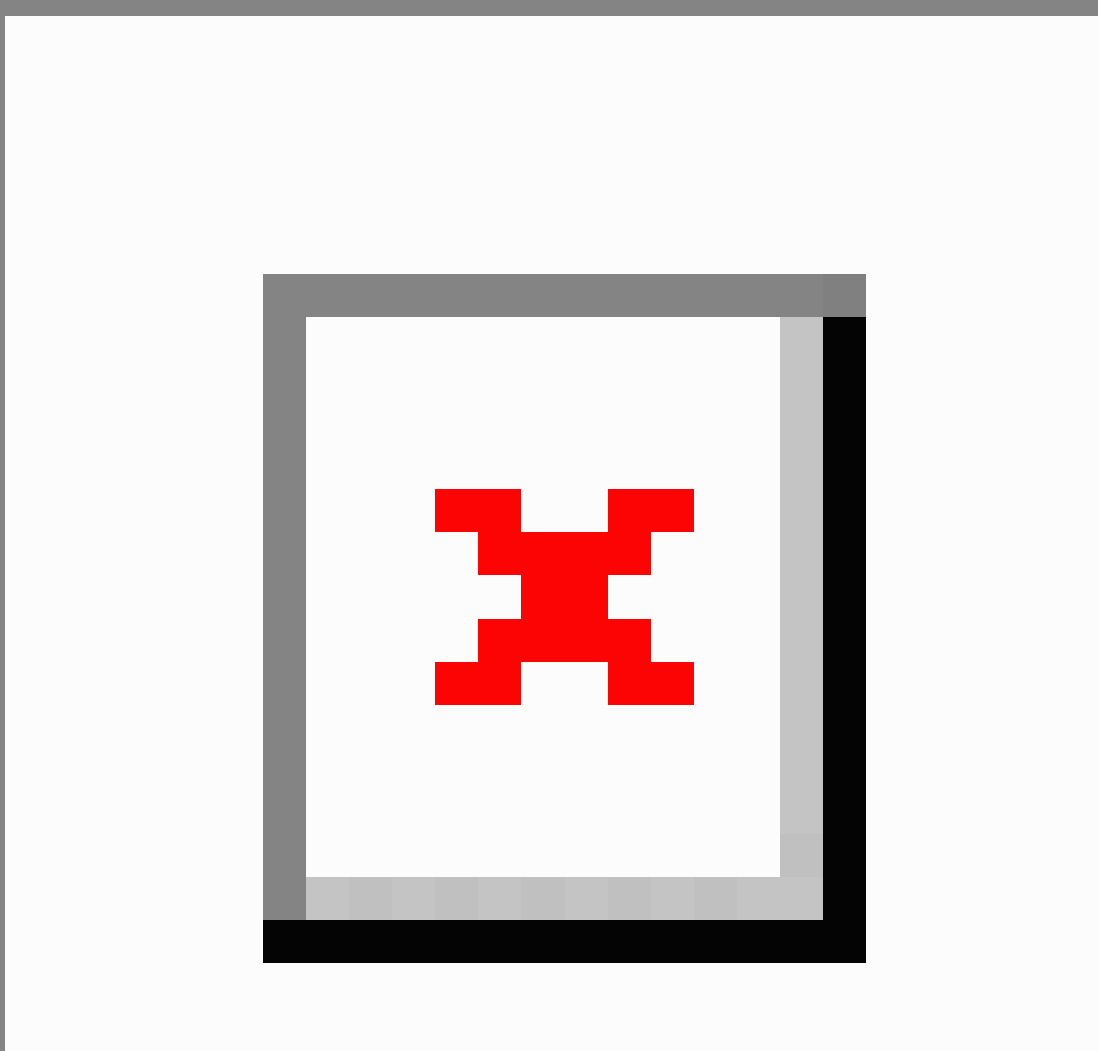
Figure 3. Example of smartphone-recorded (A) angular velocity and (B) acceleration relative to the earth coordinate system vertical axis during straight walking and a 180° turn. In a pilot trial, a participant walked straight across the laboratory before turning around a cone. Angular velocities were relatively small and contained numerous zero crossings during the straight-walking portion of the trial. Turning, on the other hand, was associated with a large nonstationarity in angular velocity between the 2 adjacent zero crossings. Acceleration patterns were noticeably altered during this period. This observation was subsequently used to develop a method to identify potential turns from walking trials collected during in-home